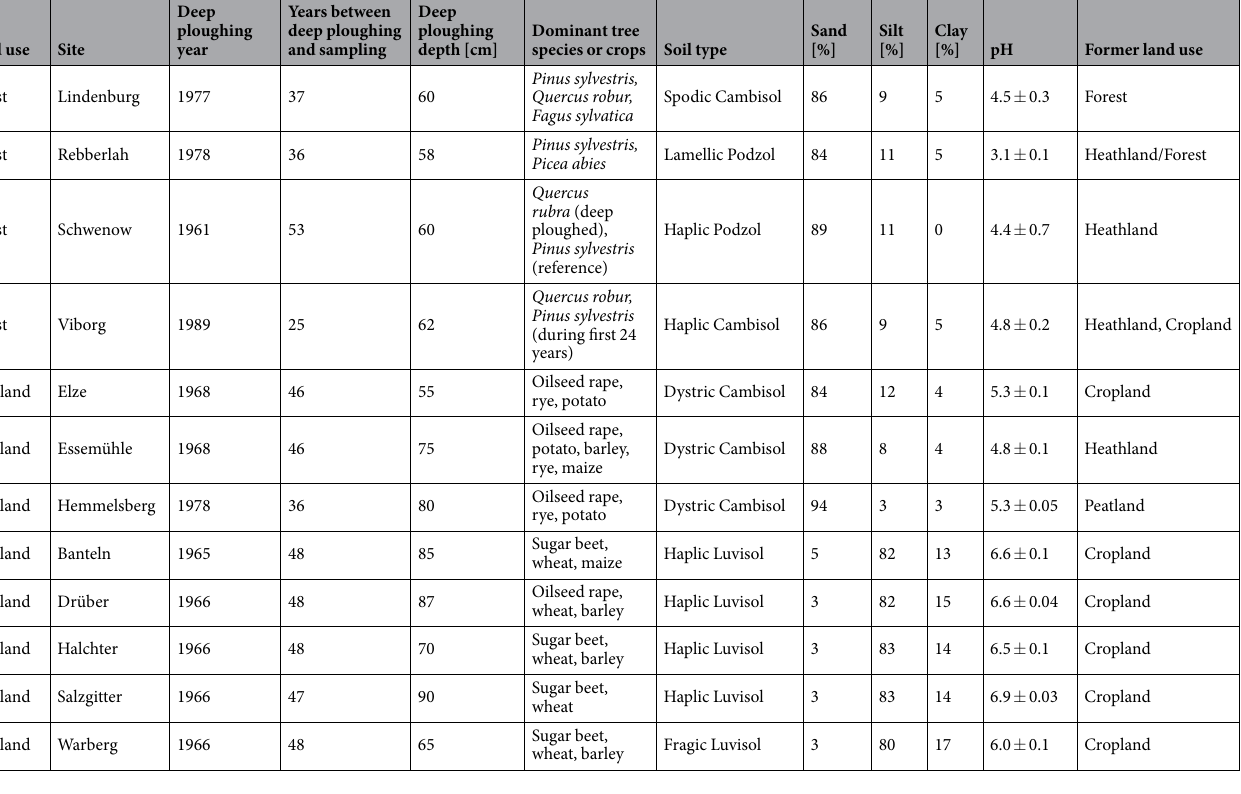
Table 1. Site characteristics. Soil properties refer to the topsoil in reference plots (texture: n = 1, pH: n = 6). Cropland data as published previously 25 .